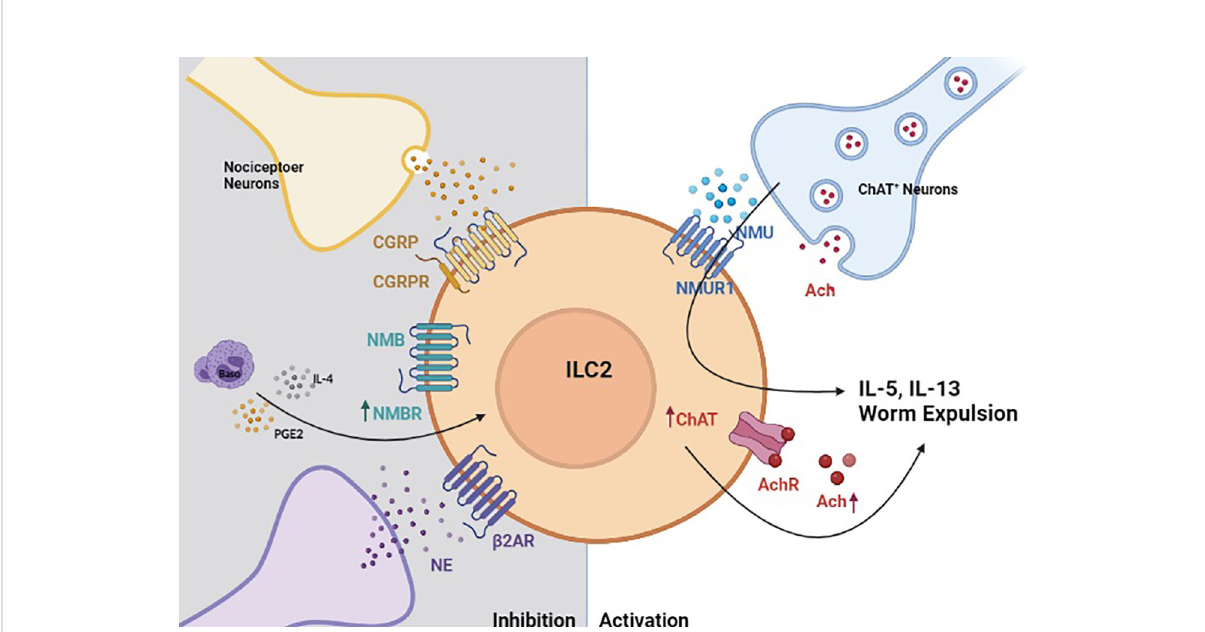
FIGURE 2 Neuro-Immune crosstalk regulates helminth-induced in fl ammation. In the context of helminth-induced in fl ammation, group 2 innate lymphoid cells (ILC2s) are activated by neuromedin U (NMU) that is released by choline acetyltransferase positive (ChAT + ) neurons (185). Activated ILC2s also upregulate ChAT to promote acetylcholine biosynthesis, which serves to further amplify their production of type 2 cytokines (184). Helminth-activated ILC2s are also restricted by neuron-derived signals. Calcitonin gene-related peptide (CGRP), neuromedin B (NMB) and sympathetic neuron-derived norepinephrine (NE) inhibit ILC2 response in a manner that properly regulated helminth-induced in fl ammation (78, 182,